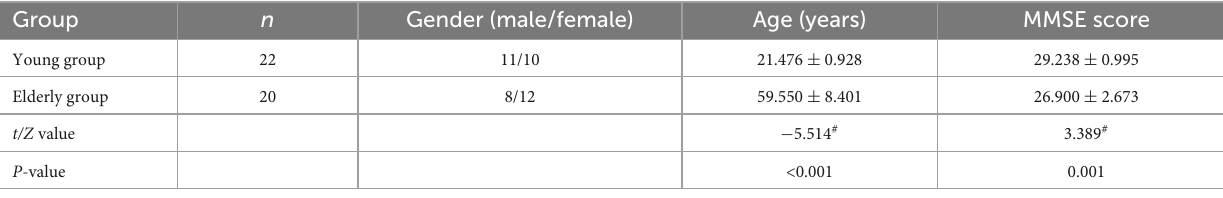
TABLE 1 Comparison of general data of two groups of subjects. Group